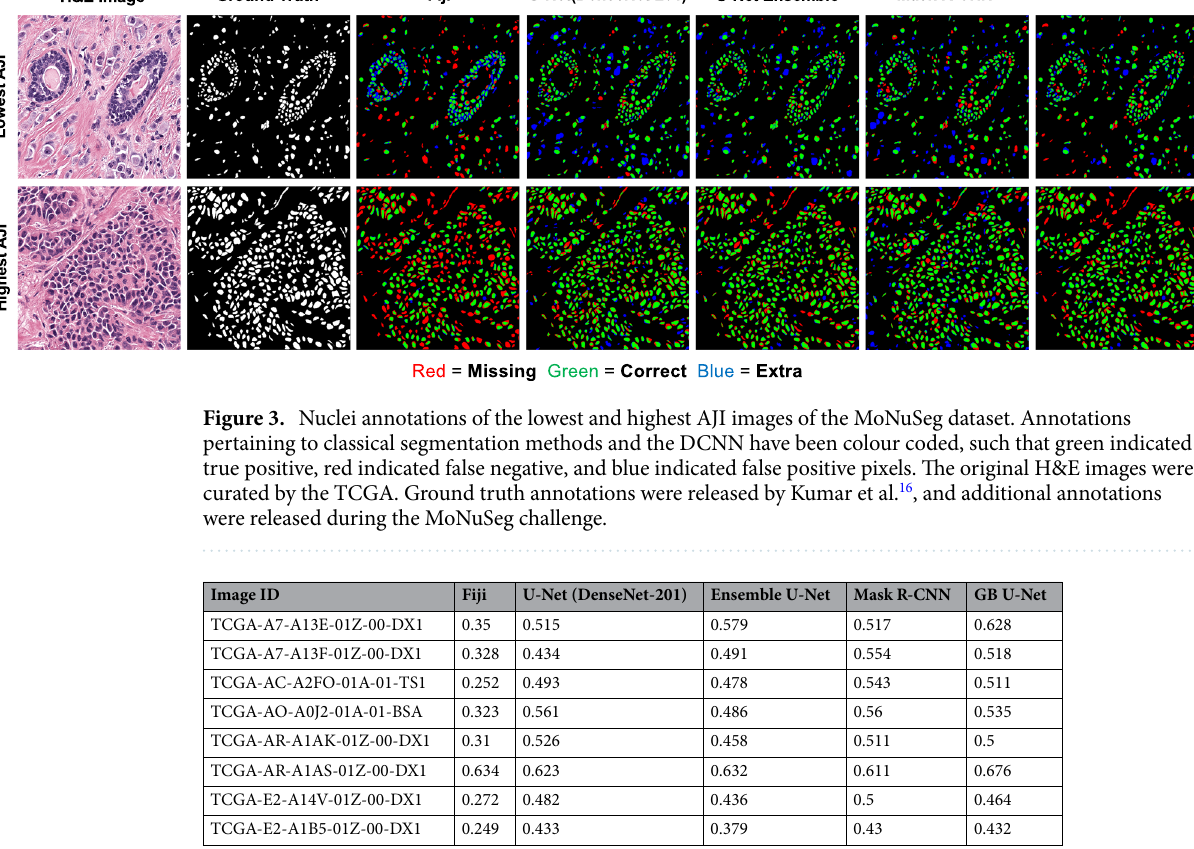
Table 3. Individual Aggregated Jaccard Index scores of the eight breast tissue images, which composed the MoNuSeg test dataset.